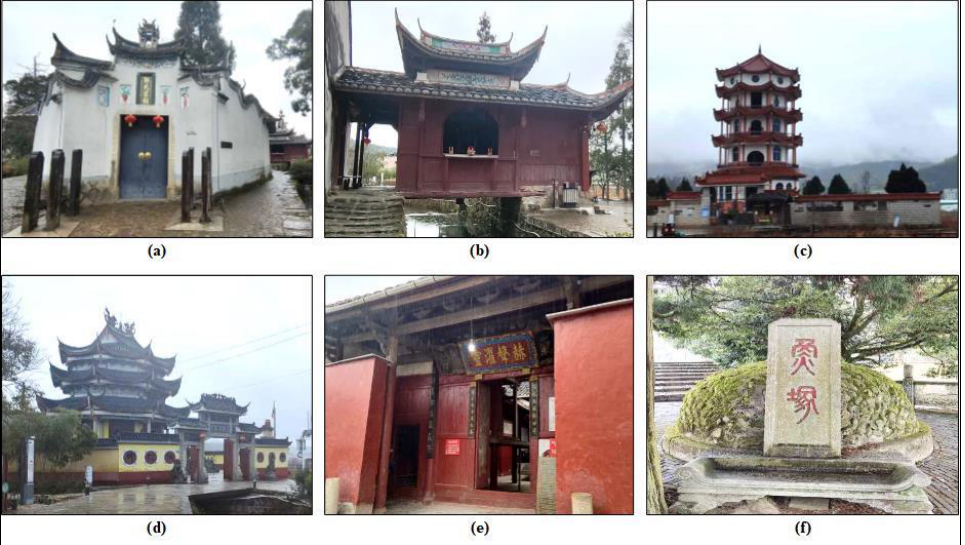
Figure 3. Several folk belief places along the Carp Brook: ( a ) Zheng’s Ancestral Hall, ( b ) Guanyin Gallery, ( c ) Wenchang Tower, ( d ) Guanyin Tower, ( e ) Tianhou Temple, and ( f ) Carp Grave.